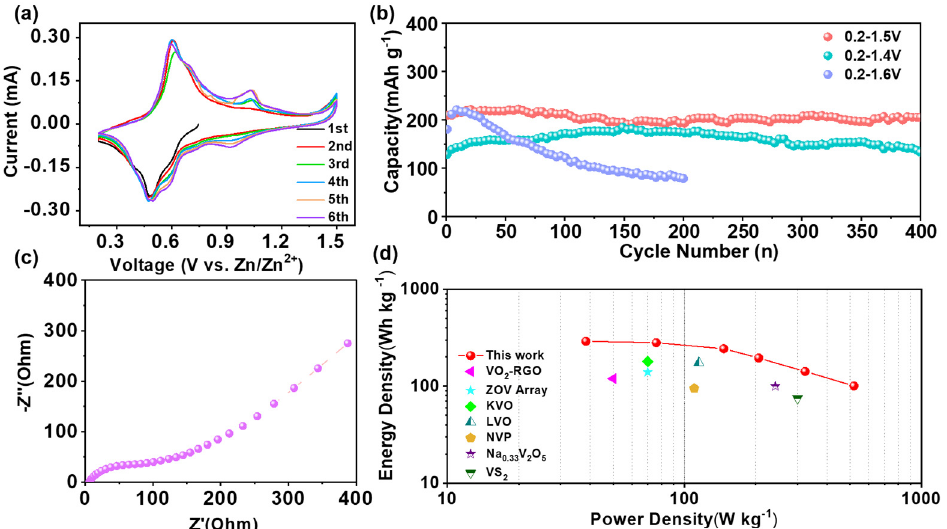
Figure 5. ( a ) The first several cycle CV curves of PO-VO 2 //Zn batteries at a voltage of 0.2–1.5 V; ( b ) the cycling performance at a current density of 1 A g − 1 under the different voltage range; ( c ) the EIS plot at 0.01–10 6 Hz; ( d ) comparison of the energy density and power density of the VO 2 //Zn battery with reported ZIBs based on different electrodes.